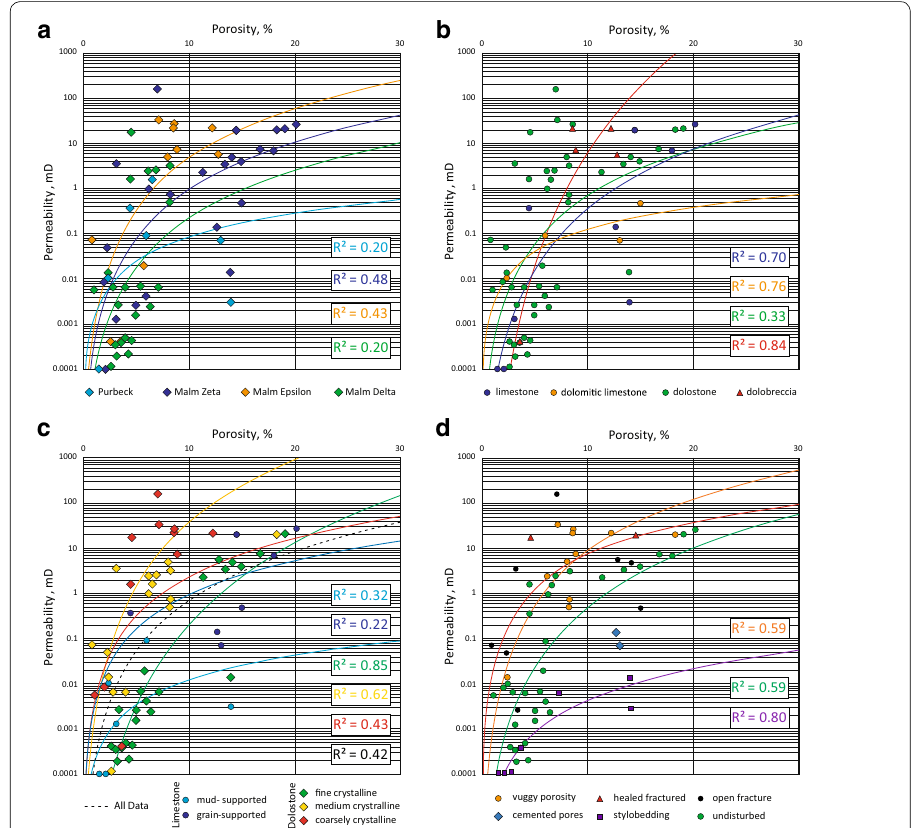
Fig. 9 Porosity–permeability relationship for measured core samples. To improve correlation, the data set was subdivided according to stratigraphic units ( a ), different lithologies ( b ), distinct petrographic rock fabrics ( c ), and secondary characteristics ( d ). Note logarithmic scale for permeability—colored lines represent power lines for each